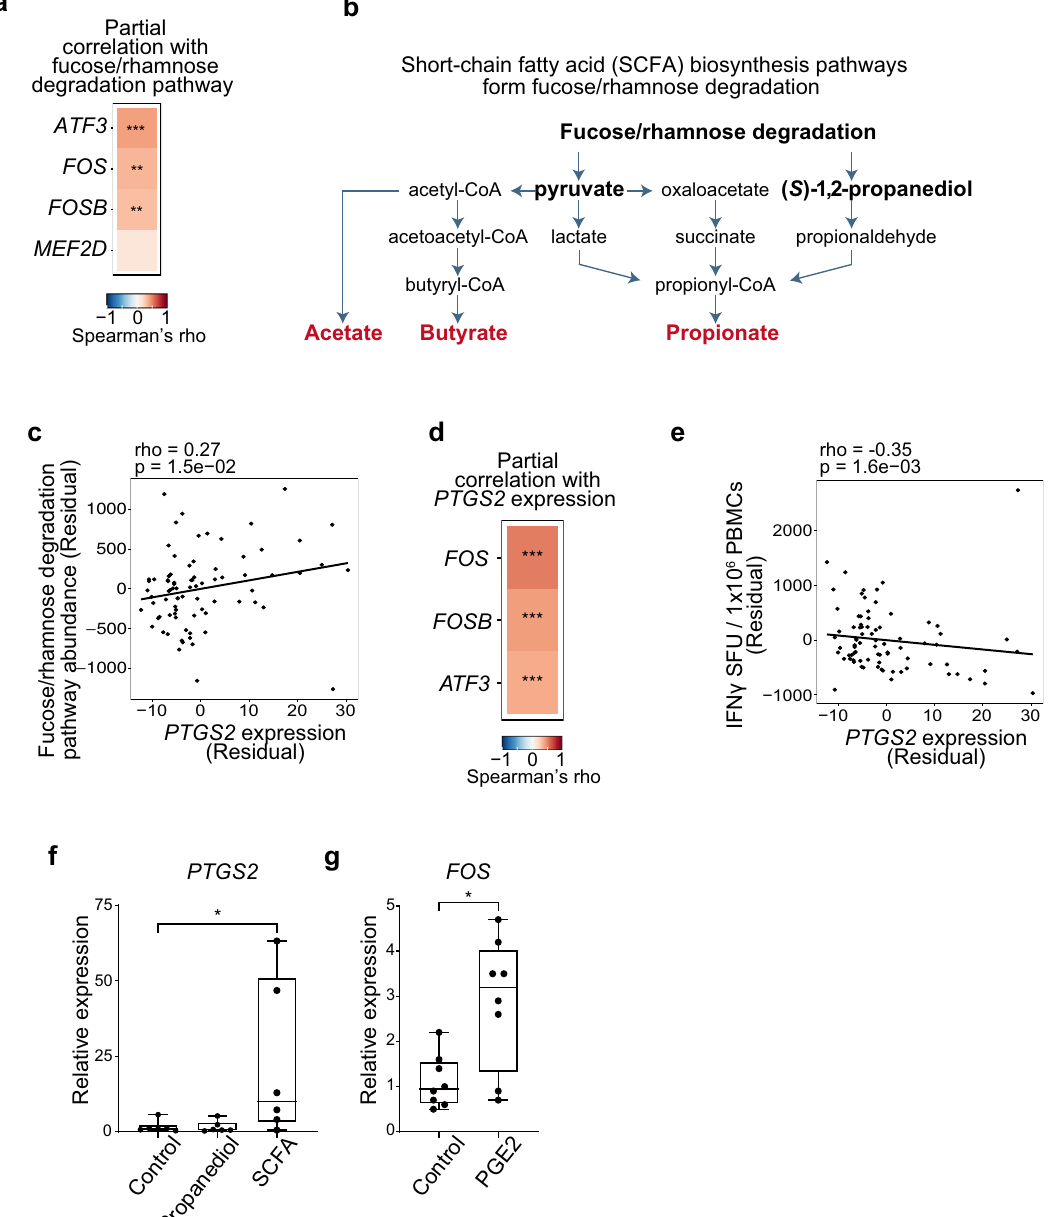
Fig. 7 The gut microbial fucose/rhamnose degradation pathway is associated with AP-1 expression. a Heat map showing the correlation between the gut microbial fucose/rhamnose degradation pathway and transcription factors associated with BNT162b2-induced T-cell responses in the entire cohort ( n = 86). b Schematic showing the production of SCFAs from the fucose/rhamnose degradation pathway. SCFAs are shown in red. c – e Correlation analysis between PTGS2 expression and fucose/rhamnose degradation ( c ), AP-1 expression ( d ), or vaccine-induced T-cell responses ( e ) in the entire cohort. a , c – e Partial correlation analyses with adjustments for age, sex, and stool sampling timing were performed with Spearman ’ s correlation tests with Benjamini – Hochberg FDR correction (** P < 0.01, *** P < 0.001). f qPCR analysis of PTGS2 mRNA levels in PBMCs untreated or treated with (S)-1,2- propanediol or SCFAs for 18 h ( n = 6). P values were calculated using Friedman test followed by Dunn ’ s multiple comparison test (* P < 0.05). g qPCR analysis of FOS mRNA levels in PBMCs untreated or treated with PGE2 for 18 h ( n = 8). The P value was calculated with the Wilcoxon signed rank test (* P < 0.05). f , g Boxes show median and 25th – 75th percentiles, and whiskers show the monocytes through epigenetic silencing, which is maintained for at least 28 days 41 . Vaccine-induced alteration of AP-1 expression levels might explain why we detected association between vaccine-induced T-cell responses and expression of FOS and ATF3 at baseline (T1), but not after vaccination (T4 or T5). AP-1 expression levels during vaccine response are associated with vaccine-induced cytokine expression 41 , but how the difference in